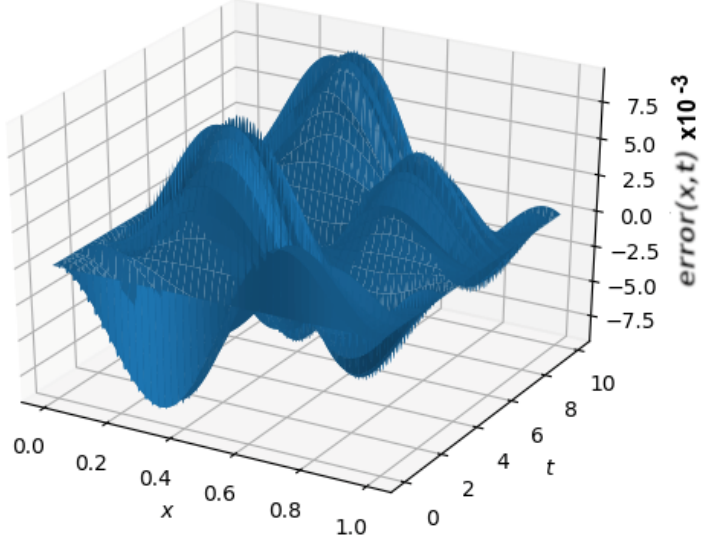
Figure 6. Error with N = 100 for Example